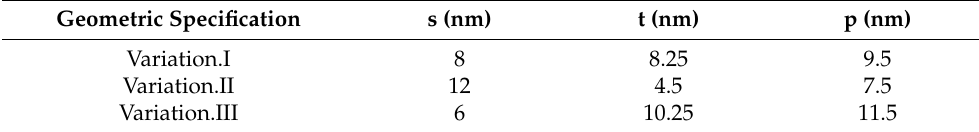
Table 2. Manipulation of size parameters on the combline graphene